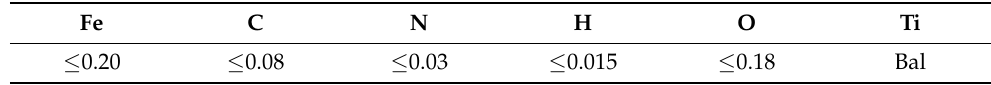
Table 1. Chemical compositions of grade 1 titanium (wt%).